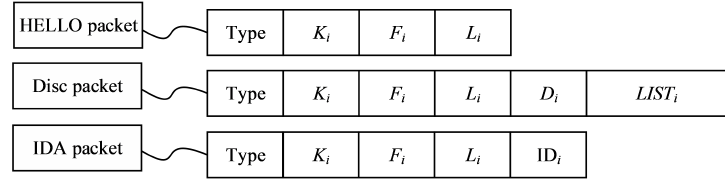
Figure 3. TD packet formats in the ETDP